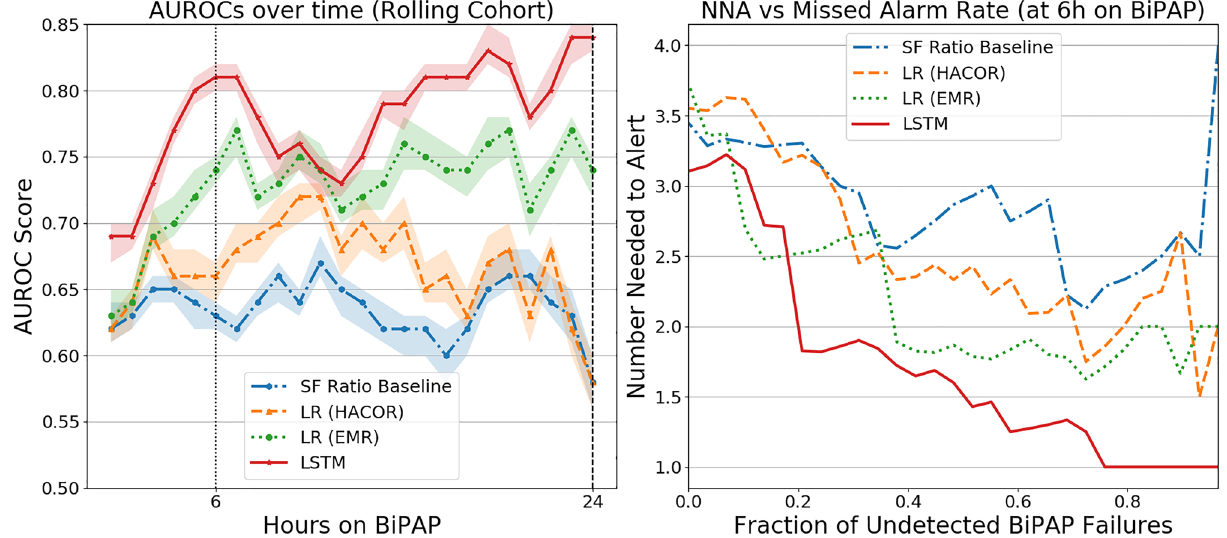
Figure 2. Model performance. (Left) Hourly AUROC values from LSTM-RNN, LR models, and S/F ratio for predicting BIPAP failure. The rolling cohort shows each model’s n -hour AUROC for BIPAP episodes with at least n -hours of BIPAP. (Right) Number needed to alert plotted as a function of missed alarm rates for predictions at 6 h after BIPAP initiation, capturing intermediate and late BIPAP failures.